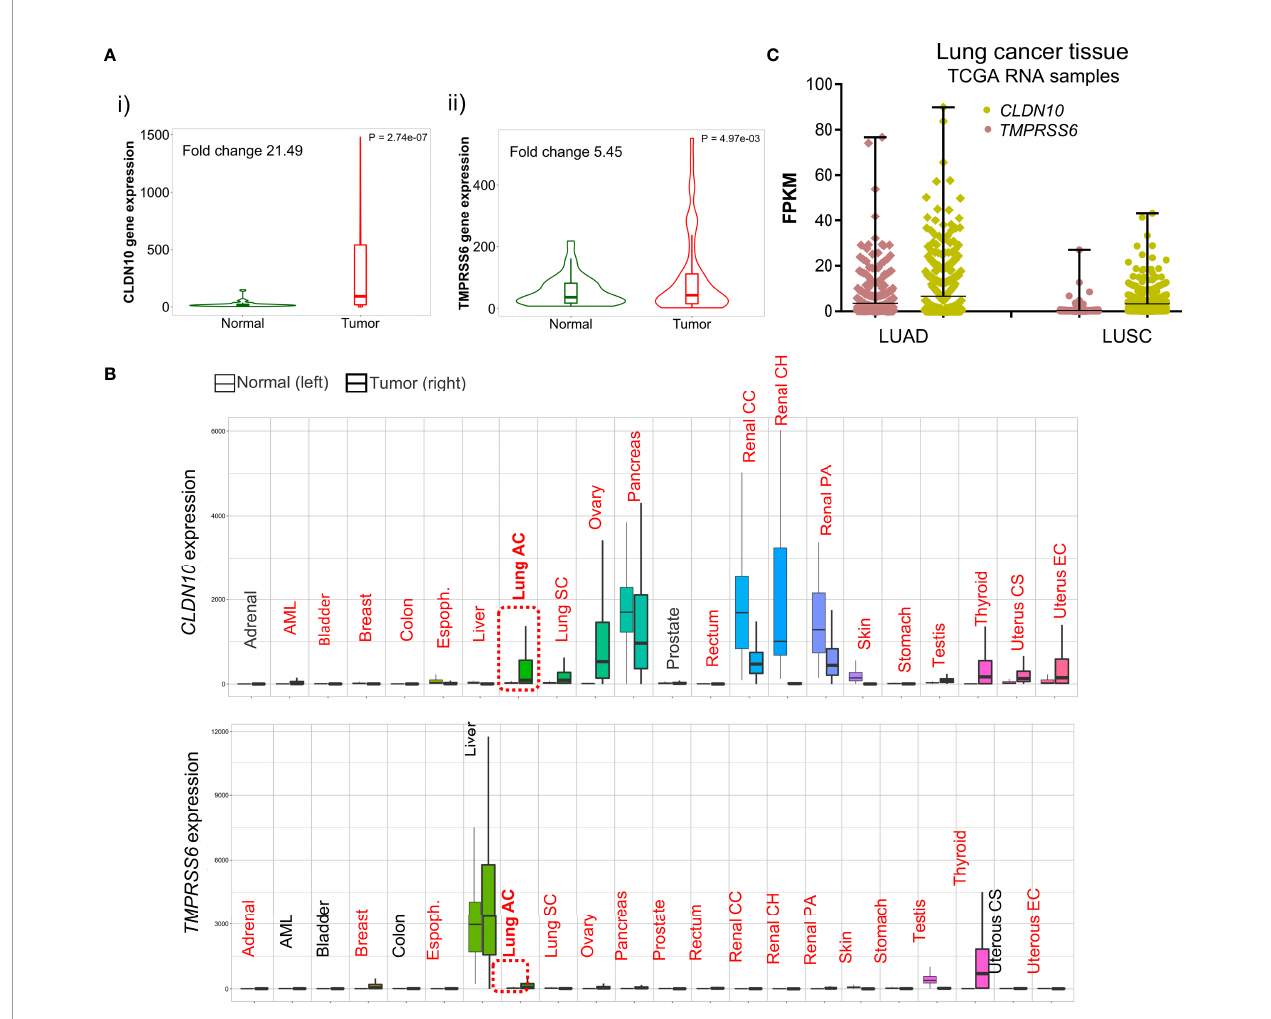
FIGURE 6 | Differential expression of CLDN10 and TMPRSS6 between normal and tumor samples. (A) Violin plot of the expression of CLDN10 (i) and TMPRSS6 (ii) in LUAD tumor sample and adjacent normal tissue. (B) Pan-cancer analysis displaysthe expression of CLDN10 and TMPRSS6 genes across all tissues comparingtumoral andnormal ones. Highlighted inred those tissues with statisticalsigni fi cance (p<0.01) differential expression by a Mann – Whitney U test. (C) Graph that illustrates the RNA of CLDN10 (pistachio) and TMPRSS6 (salmon) in fragments per kilobase per million mapped reads(FPKM) in NSCLChistological subtypes LUAD and